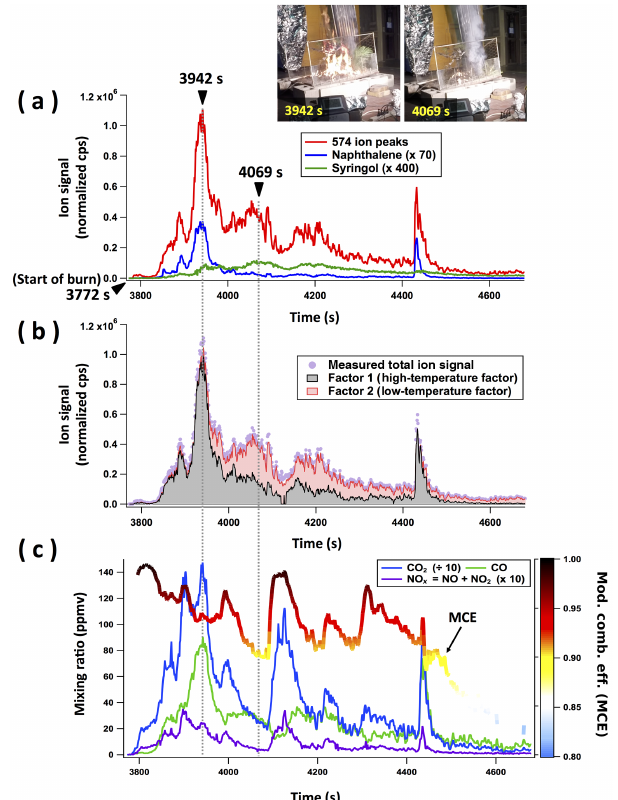
Figure 1. Results for an example burn of ponderosa pine realis- tic mixture (Fire no. 37). (a) Time series of ion signals of 574 ion peaks, naphthalene (C 10 H 8 · H + , m/z 129.070), and syringol (C 8 H 10 O 3 · H + , m/z 155.070). (b) PMF results of two-factor solu- tion. The grey and pink colors are stacked, not overlapped. (c) Time series of mixing ratios of CO 2 , CO, and NO x measured by open- path Fourier transform infrared (OP-FTIR) optical spectroscopy and the modified combustion efficiency (MCE) (Selimovic et al., 2018). The MCE trace is colored by the key and scale on the